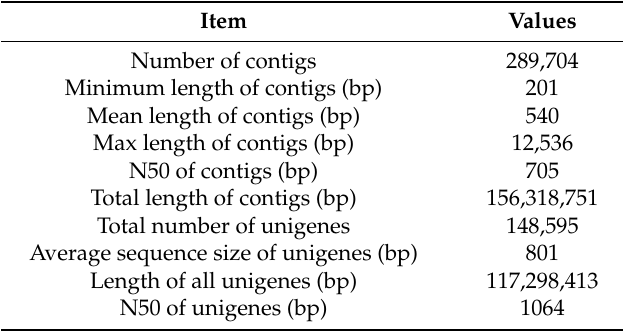
Table 2. Summary of de novo transcriptome